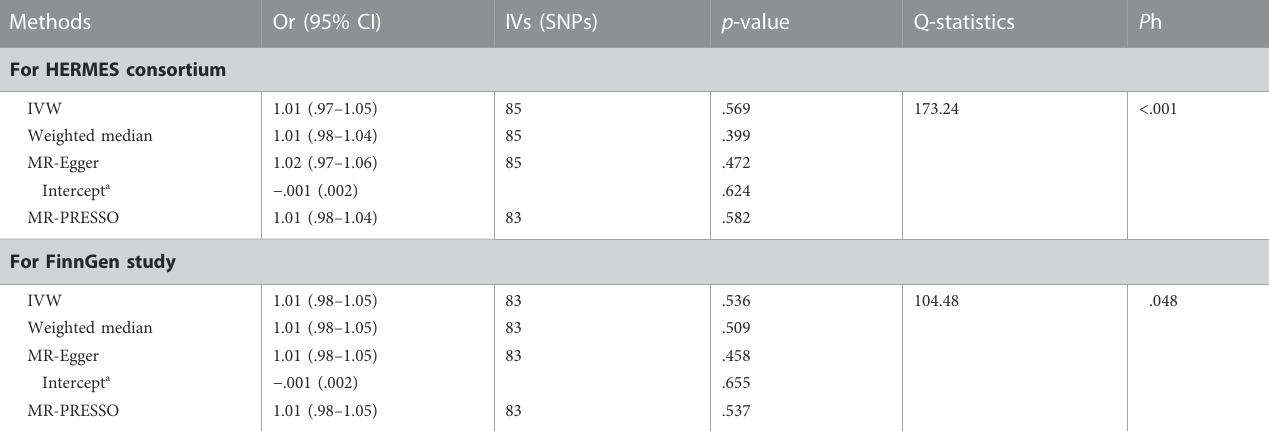
TABLE 2 Association between genetically determined bilirubin and heart failure in European Population. Methods